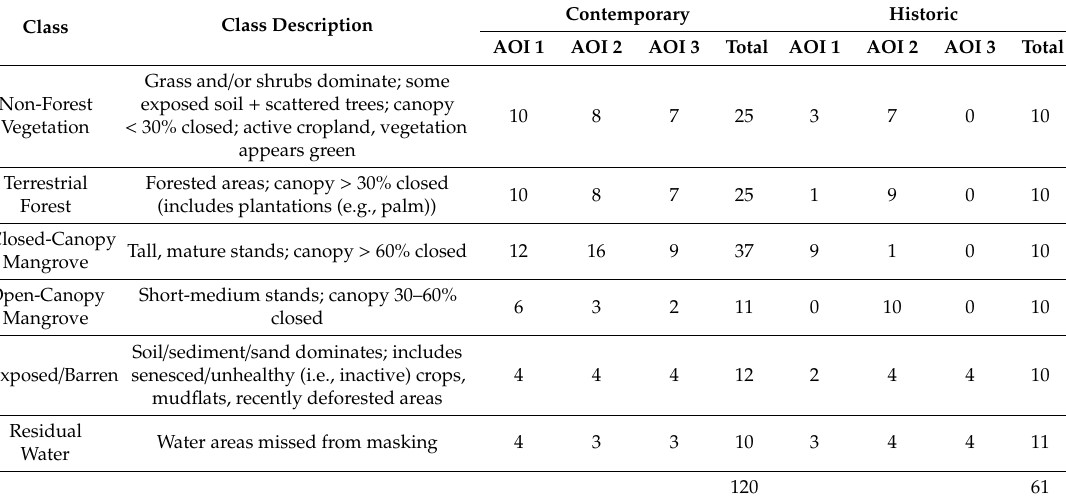
Table 4. Names and description of classes and numbers of classification reference areas (CRAs). Also shown is how many CRAs were derived within each sub-national CRA AOI (Figure